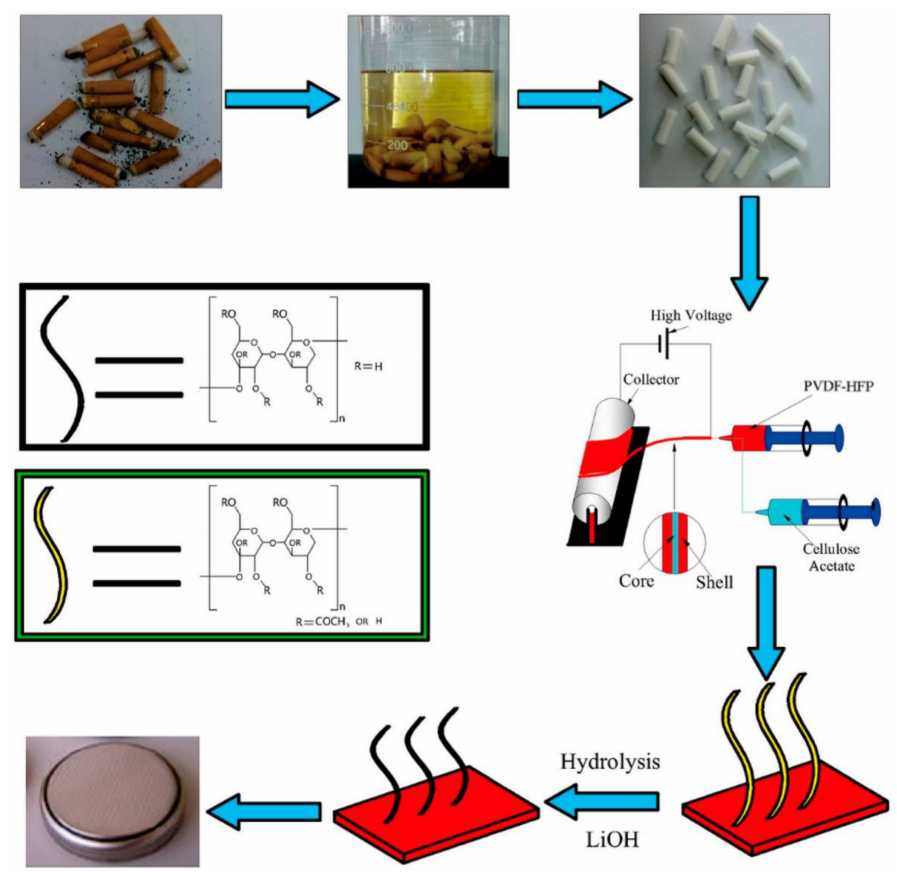
Figure 7. Preparation of PVDF-HFP/CA nanofiber separators for lithium ion batteries [140], with copyright permission from the American Chemical